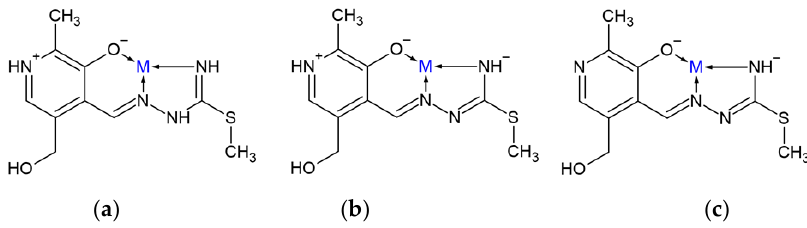
Scheme 2. Coordination models and ligand forms: ( a ) neutral, ( b ) mono- and ( c ) dianionic.